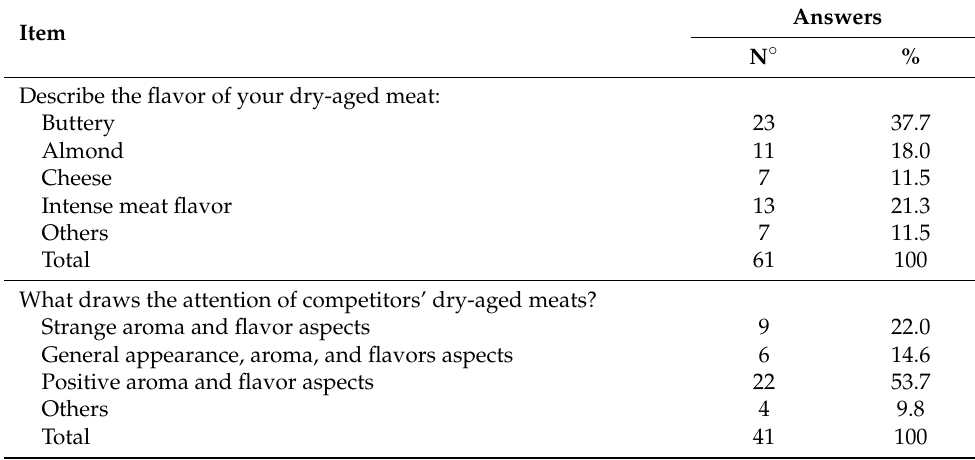
Table 9. Sensory attributes of dry-aged meat in